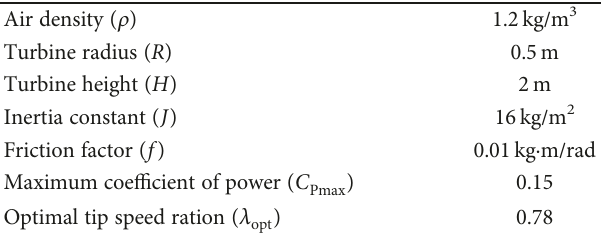
Figure 6: Aspect of rotor speed-based mechanical power in proportion to di ff erent wind Table 2: Wind turbine speci fi cations [30].